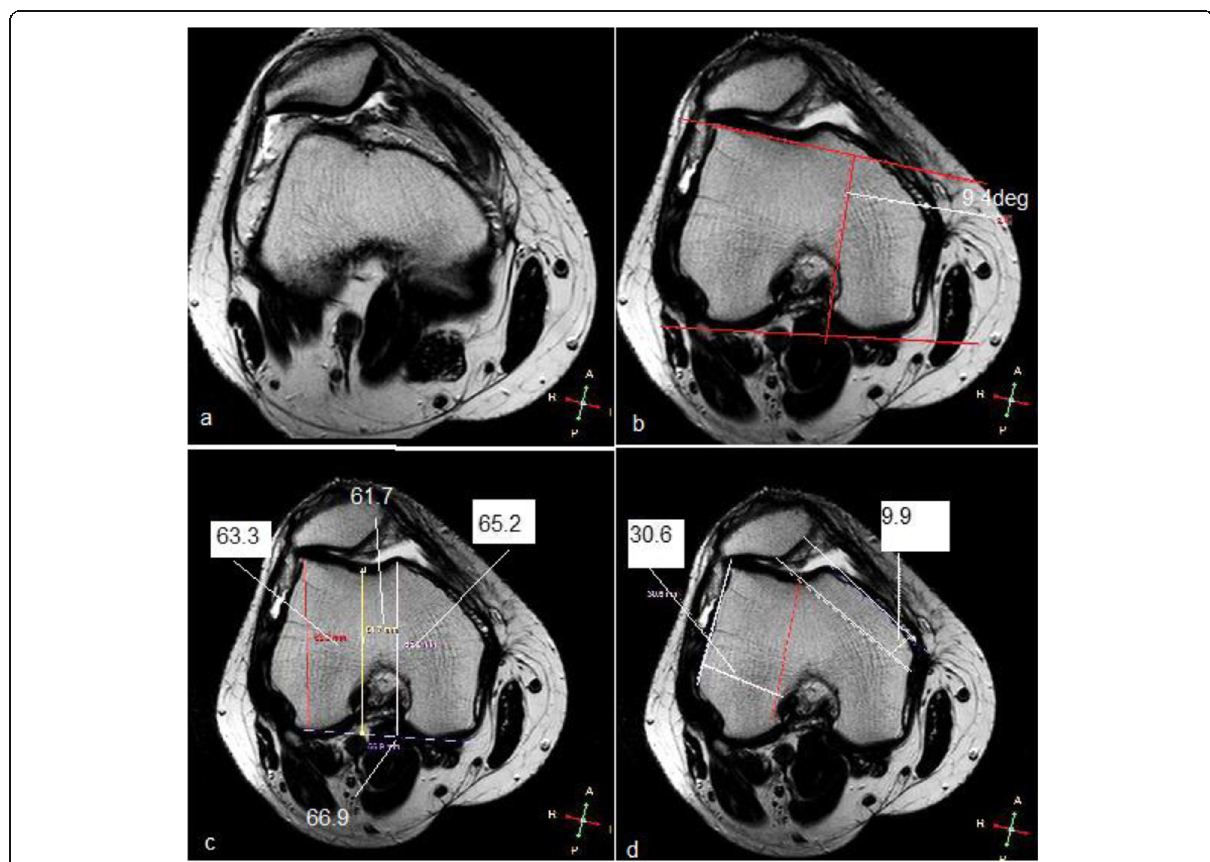
Fig. 14 a – d MRI images for lateral patellar subluxation with trochlear dysplasia type C as a predisposing factor. a Axial T2WI demonstrated loss of contact between the patellofemoral joint surfaces laterally. b Axial T2WI demonstrated a lateral inclination angle about 9.4°. c Axial T2WI demonstrated a trochlear groove depth about 2 mm. d Axial T2WI demonstrated a trochlear facet asymmetry